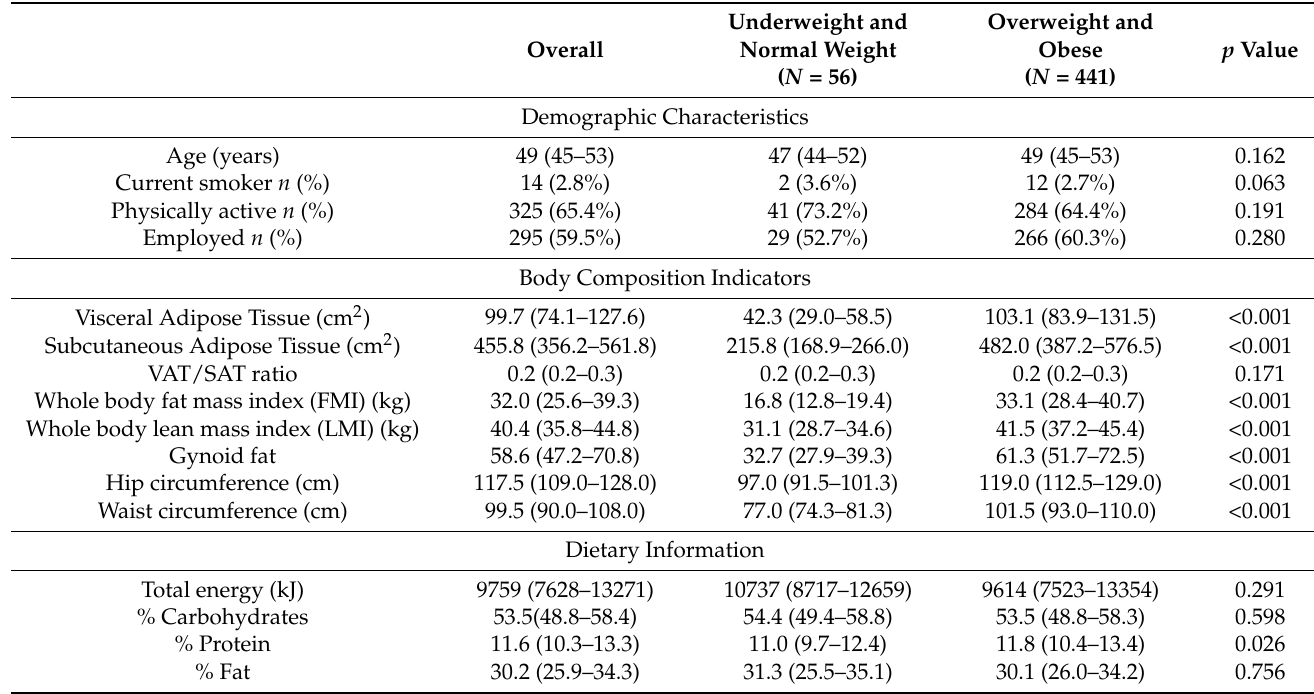
Table 1. Descriptive characteristics for the study population according to